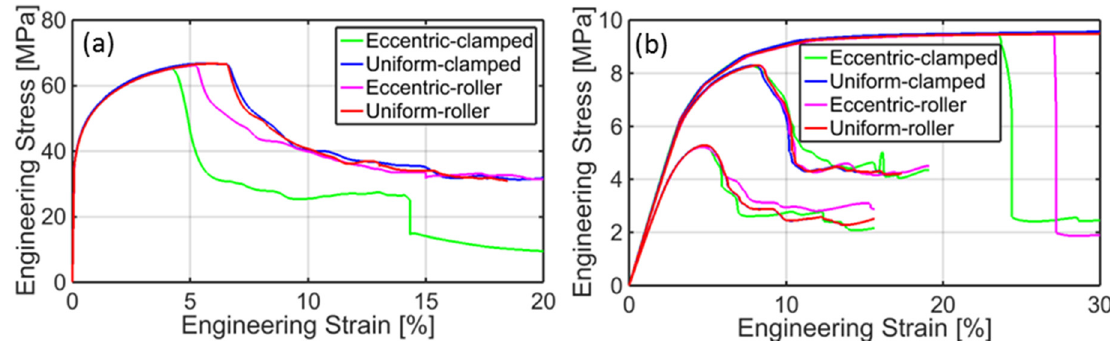
Figure 9. Nominal stress versus nominal strain relationship resulting from the simulation of tensile tests concerning: ( a ) plain aluminum; ( b ) notched